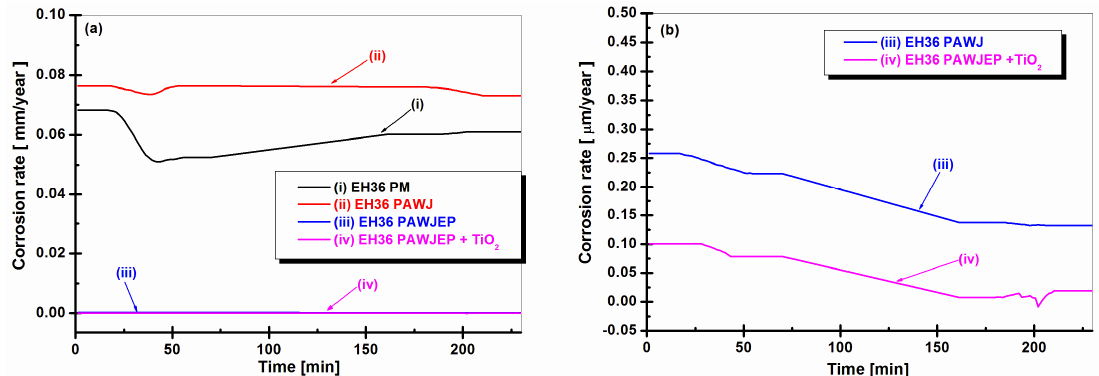
Figure 9. Evolution of corrosion rate during immersion period ( a ) for: (i) EH36PM without protective coating used like parent material, (ii) EH36PAWJ welded steel without protective coating, (iii) EH36PAWJEP coated with polymeric primer and (iv) EH36PAWJEP + TiO 2 coated with nanocomposite polymeric primer reinforced with dispersed TiO 2 nanoparticles and ( b ) in low corrosion rate value for (iii) and (iv).